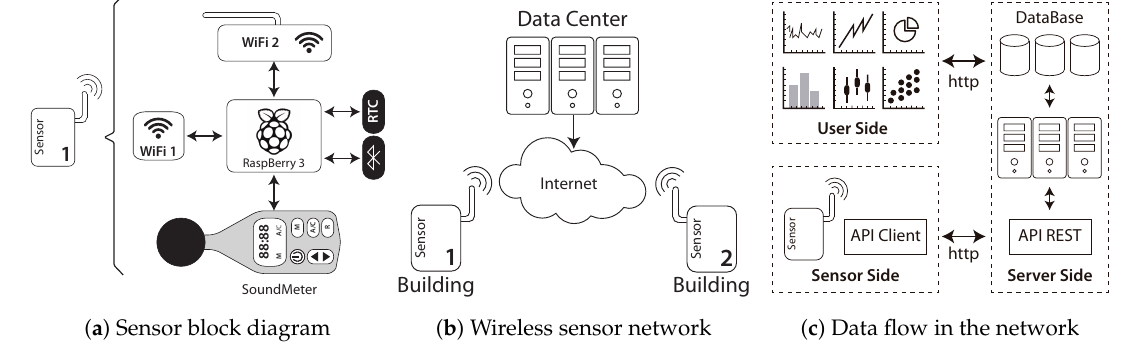
Figure 1. Different elements and views of the road-sensor system